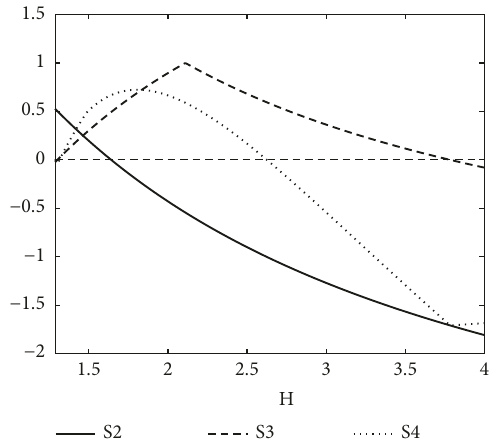
Figure 9: Graphs of Jury criteria 𝑆2 , 𝑆3 , and 𝑆4 , cf. (34) and (37).